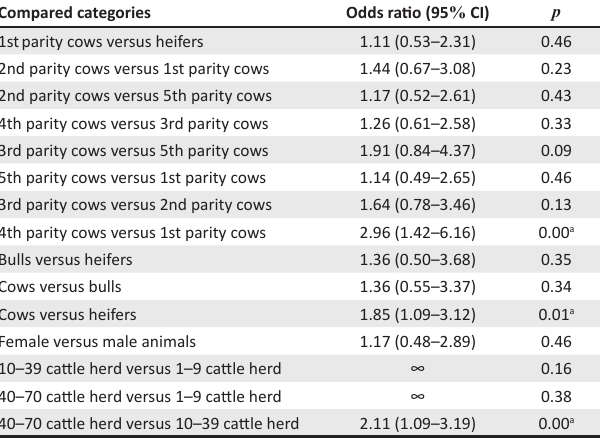
TABLE 4: Odds ratios, confidence intervals and p -values of different categories of cattle. Compared